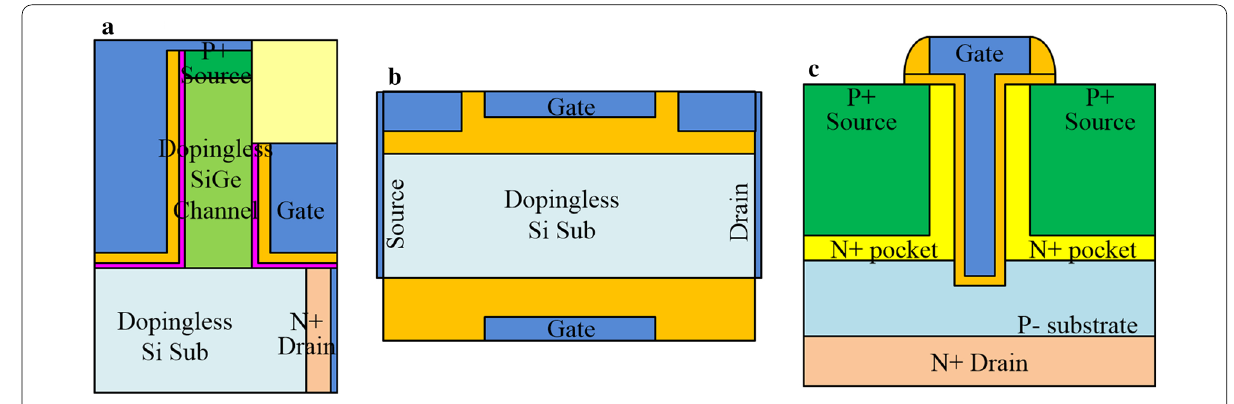
Fig. 2 Structure of a DF-TFET, b DL-TFET, c TG-TFET